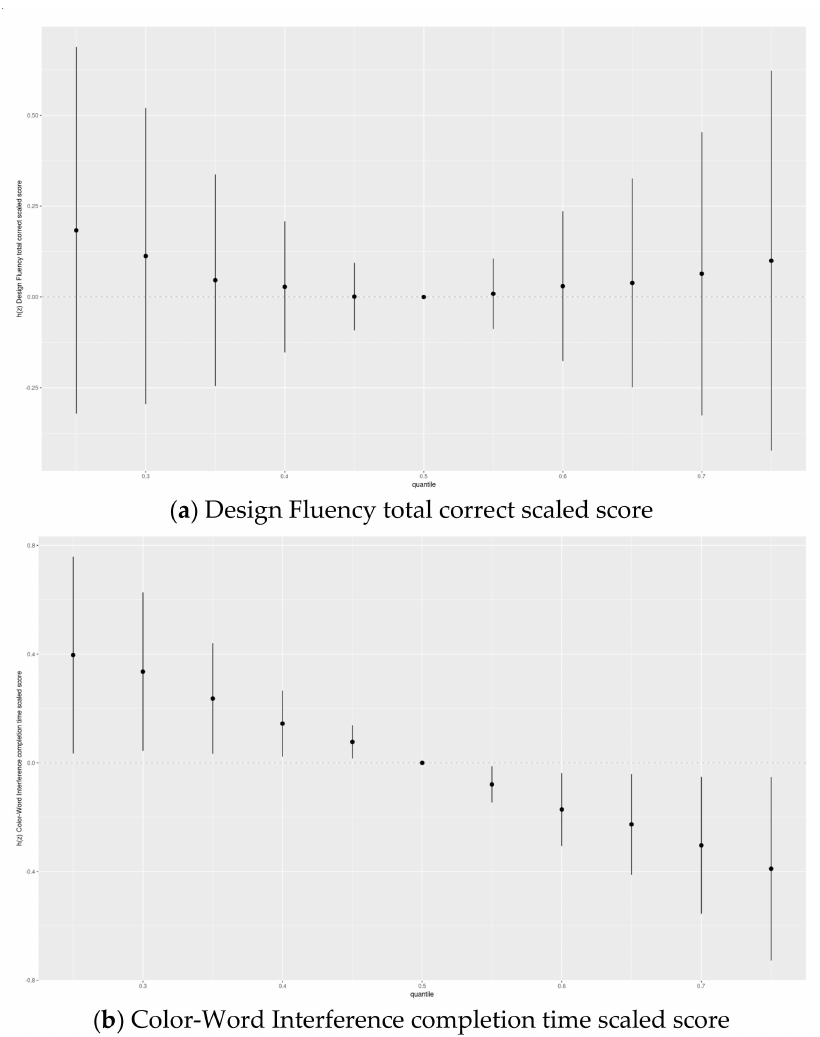
Figure 4. Joint association (estimates and 95% credible intervals) 1 of the five-chemical mixture 2 (DDE, HCB, Σ PCB 4 , Pb and Mn) with the Delis–Kaplan Executive Function System inhibition scaled scores: ( a ) Design Fluency total correct scaled score and ( b ) Color–Word Interference completion time scaled scores among adolescents in the main analysis group. Chemical mixture levels at each percentile are compared to a mixture with each component at its median level. 1 Exposures have been log2-transformed and models have been adjusted for child race, sex, age at exam, year of birth, and HOME score; maternal marital status at child’s birth, IQ, seafood consumption during pregnancy, and smoking during pregnancy; maternal and paternal education and annual household income at child’s birth; and study examiner. 2 Set 1: complete outcome, covariate and exposure data for DDE, HCB, Σ PCB 4, Pb and Mn, n = 373. Abbreviations: DDE: dichlorodiphenyldichloroethylene; HCB: hexachlorobenzene; Σ PCB 4 : Sum of 4 PCB congeners (118, 138, 153, 180); Pb: lead; Mn: